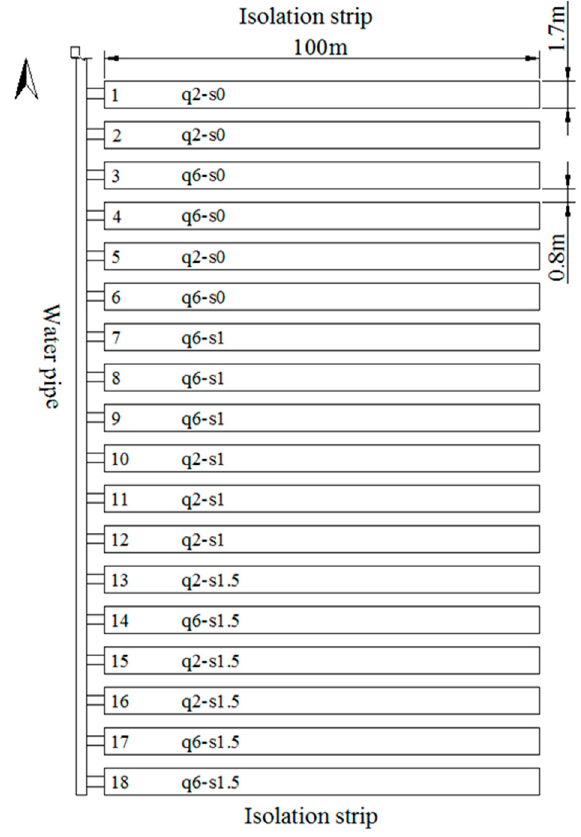
Table 2. Experimental treatments.